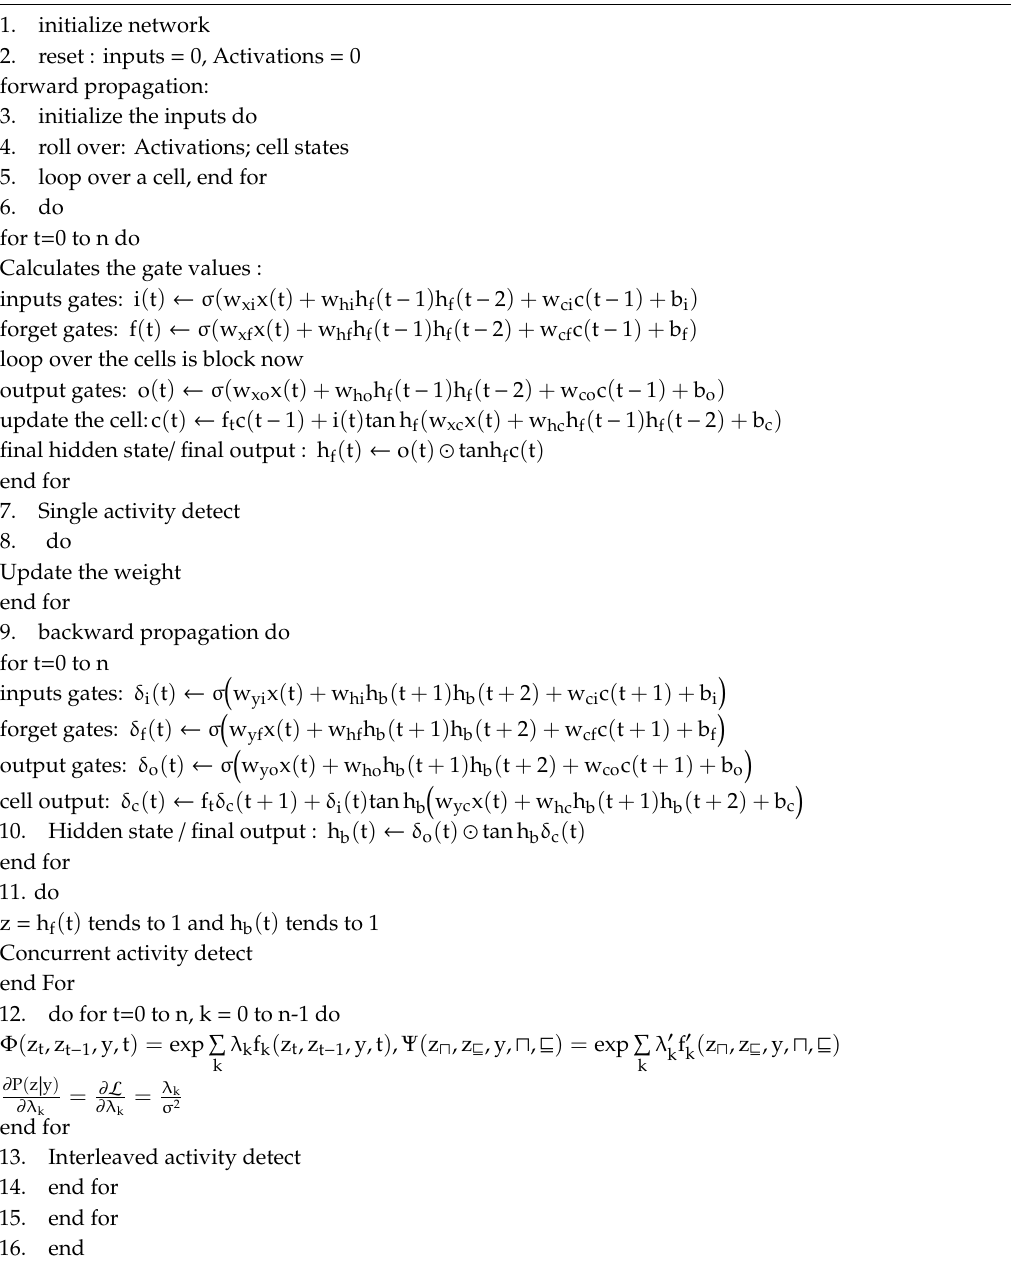
Algorithm 1 pseudocode for the proposed